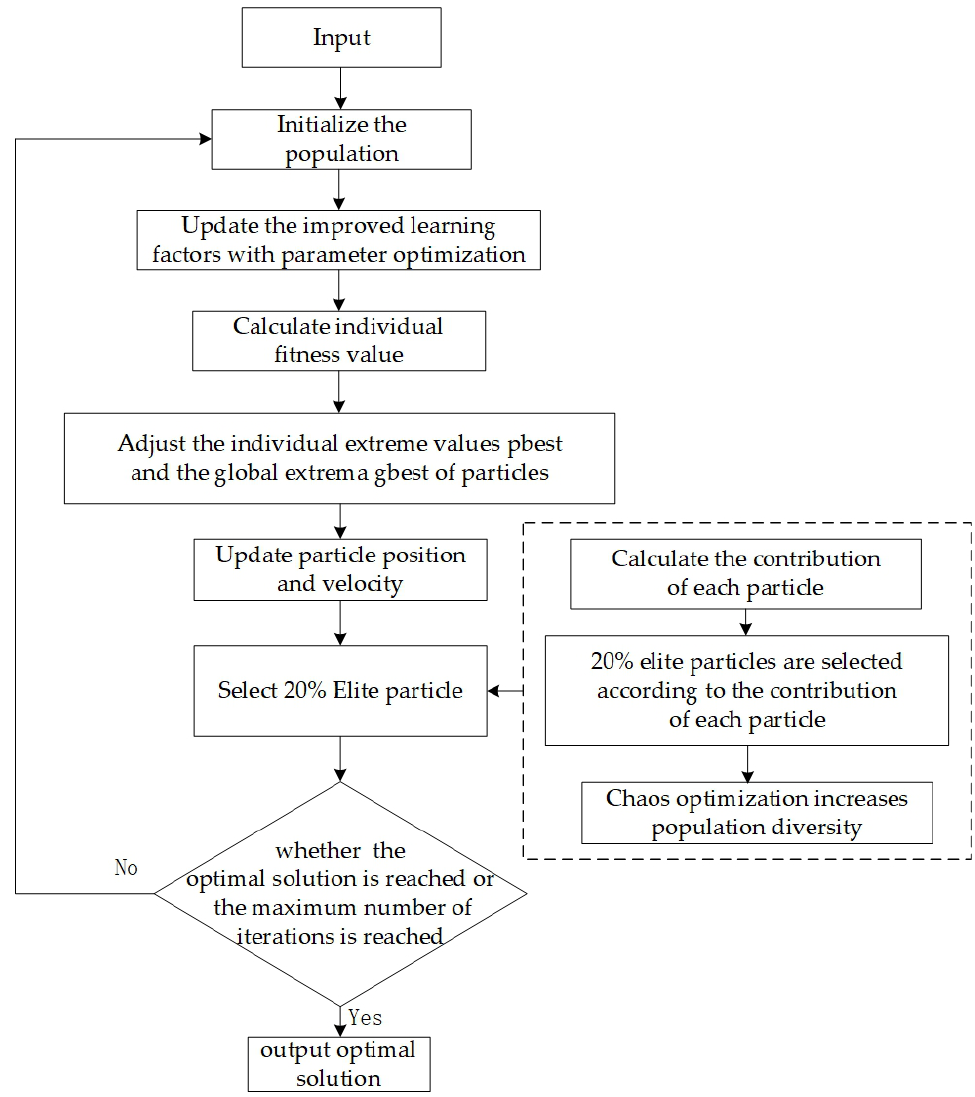
Figure 2. Improved particle swarm algorithm